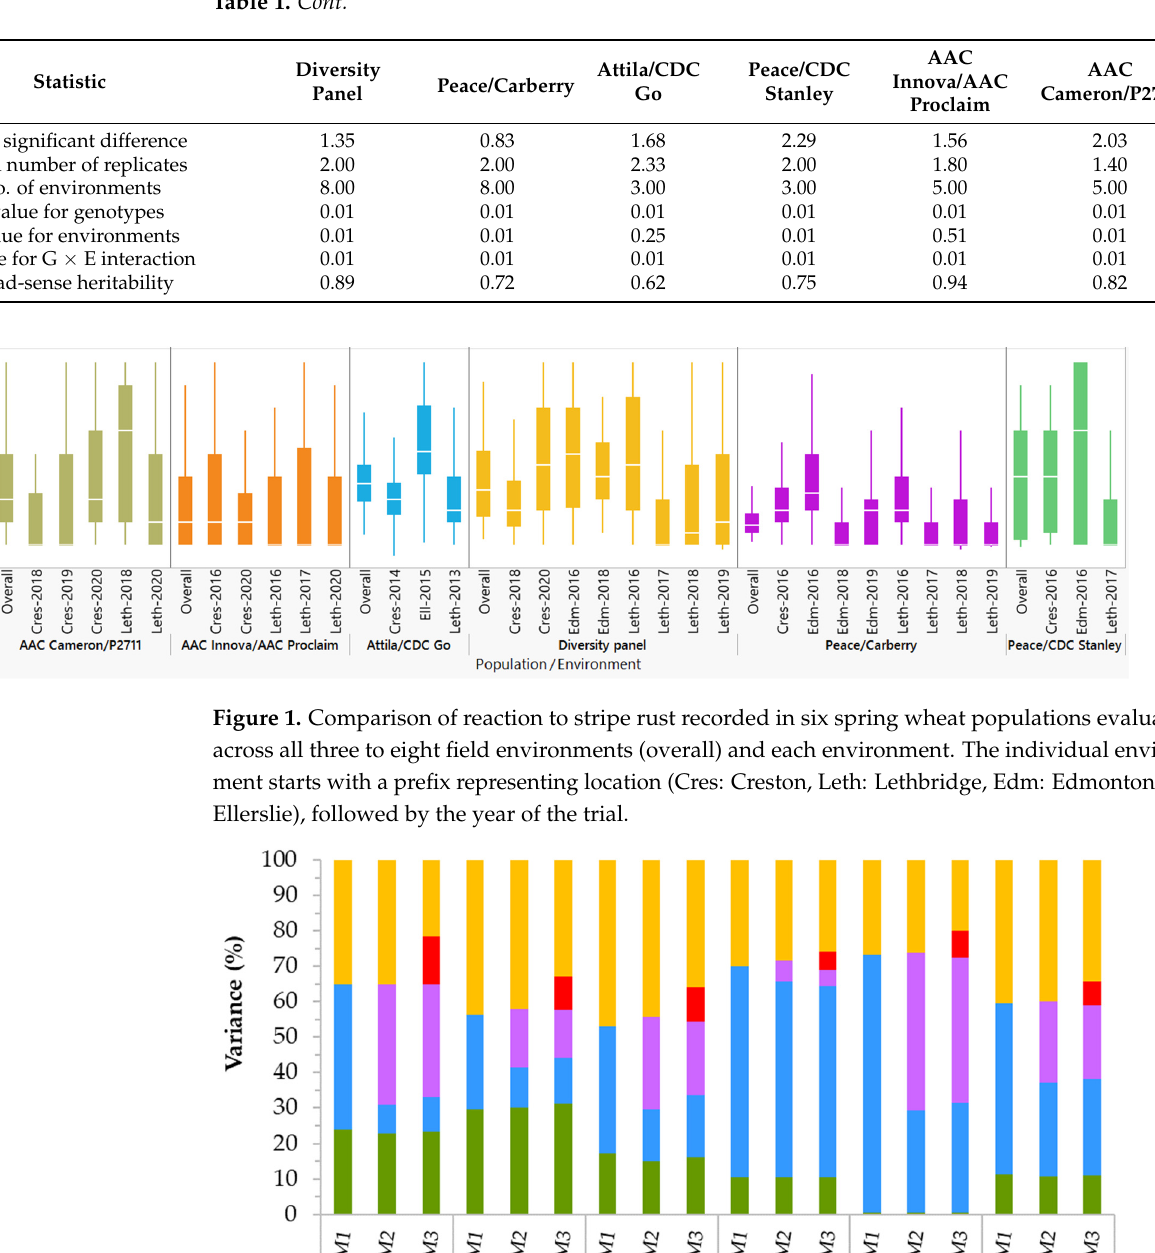
Figure 2. Partitioning of total variance components into environments (E), genotypes (L), molecular markers (M), interactions between genotypes and environment (GEI), and residual (R) components using the baseline M1 model, the main effect reaction norm M2 model, and the M3 model that in ‐ corporated GEI. Population codes are as follows: AMP (diversity panel), PAC (Peace/Carberry),